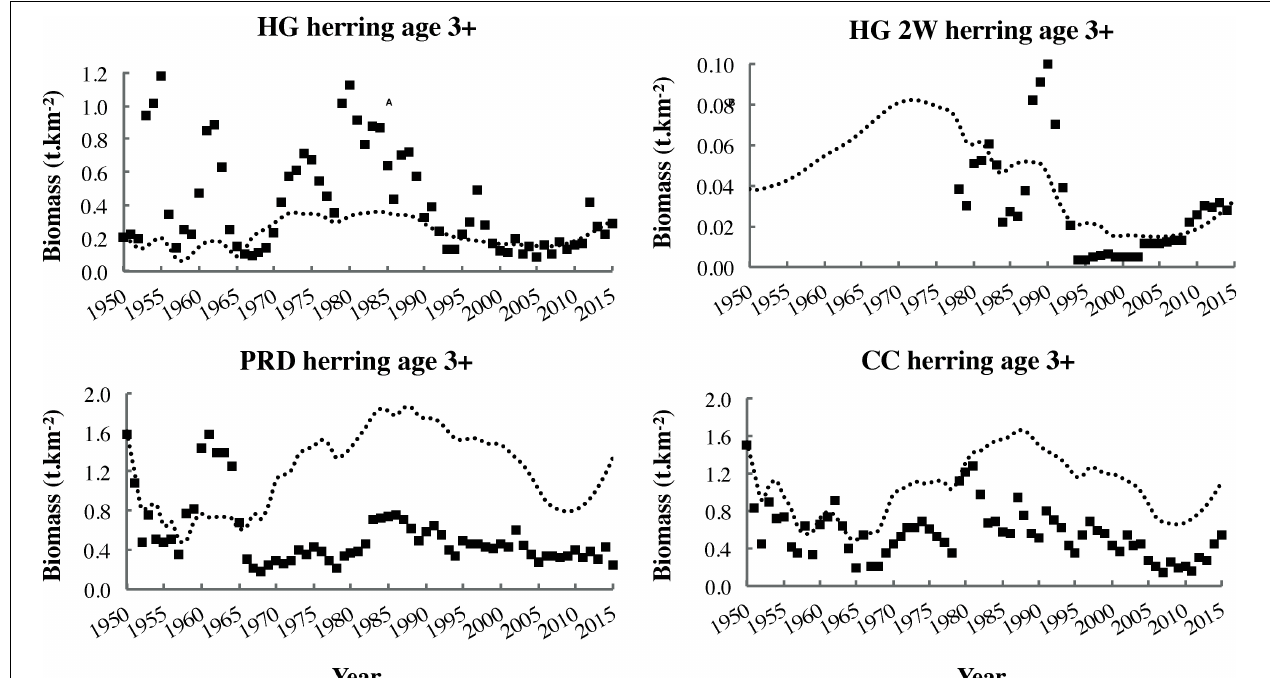
FIGURE 7 | Biomass time series (squares) and dynamic ecosystem simulation outputs (most parsimonious fit, dotted lines) for adult (age 3+ years) classes of the four local herring stocks.